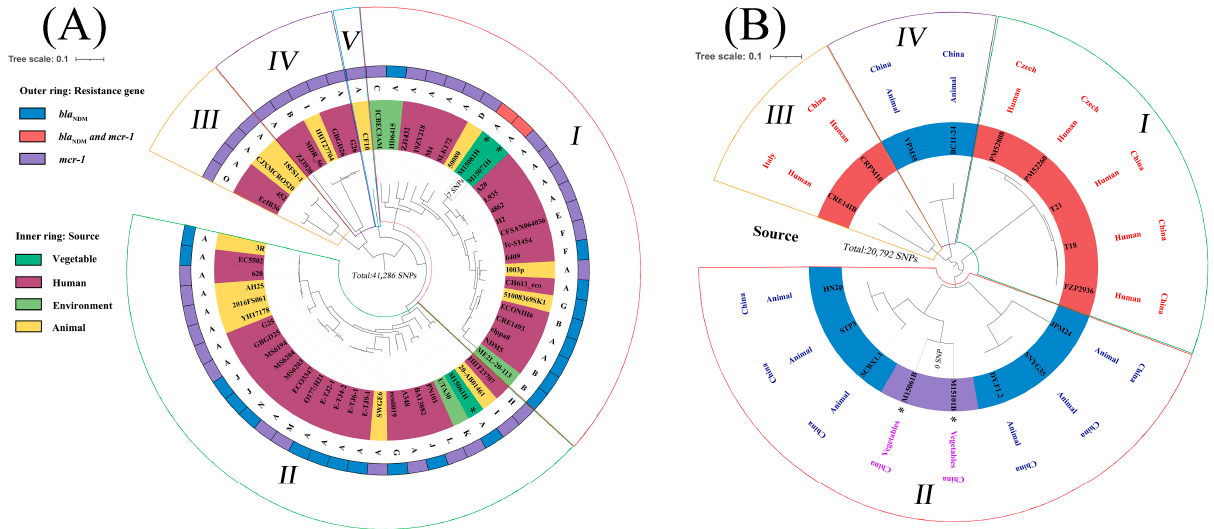
Figure 1. Phylogenetic tree of E. coli harboring mcr ‐ 1 and/or bla NDM ( A ) and bla NDM ‐ positive P. mirabilis ( B ) by core genome sequences visualized using iTOL v6. ( A ) Phylogenetic tree of E. coli possessing mcr-1 and/or bla NDM from different origins and countries, including 57 genome sequences from NCBI and 3 isolates in this study. Strain M15061H in this study was used as a reference. A–O represent different countries, namely A: China, B: United States, C: Brazil, D: Lebanon, E: Denmark, F: Colombia, G: Switzerland, H: Italy, I: Germany, J: India, K: Ecuador, L: Thailand, M: Netherlands, N: United Kingdom and O: Bolivia. ( B ) Phylogenetic tree of bla NDM ‐ positive P. mirabilis isolates from different origins and countries, including 15 genomes from NCBI and 2 isolates in this study. Strain M15061B in this study was used as a reference. Different clades were marked with different colored sectors. The genomes labeled with “*” were collected from vegetables in this study.